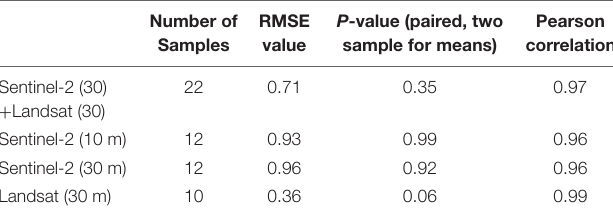
Number of RMSE P -value (paired, two Samples value sample for means)